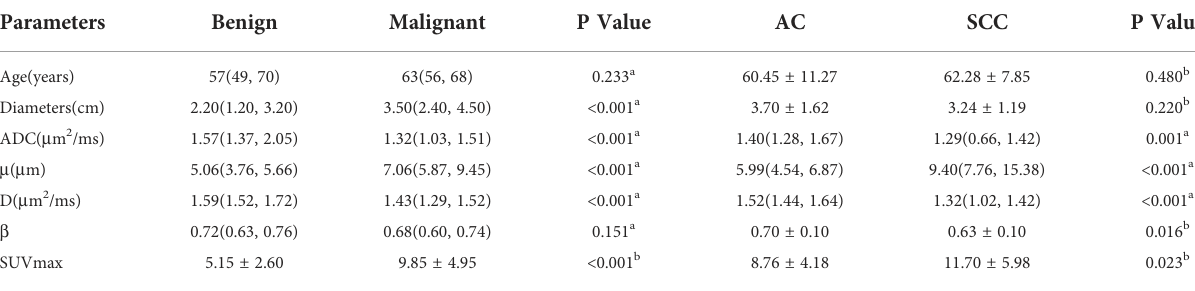
Data were expressed as mean ± standard deviation (SD) or median ( fi rst quartile, third quartile) depending on whether the normal distribution is being followed. AC, adenocarcinoma; SCC, squamous cell carcinoma. P < 0.05 indicates that the difference is statistically signi fi cant. a Comparisons were performed by Mann – Whitney U test. b Comparisons were performed by independent sample t-test.